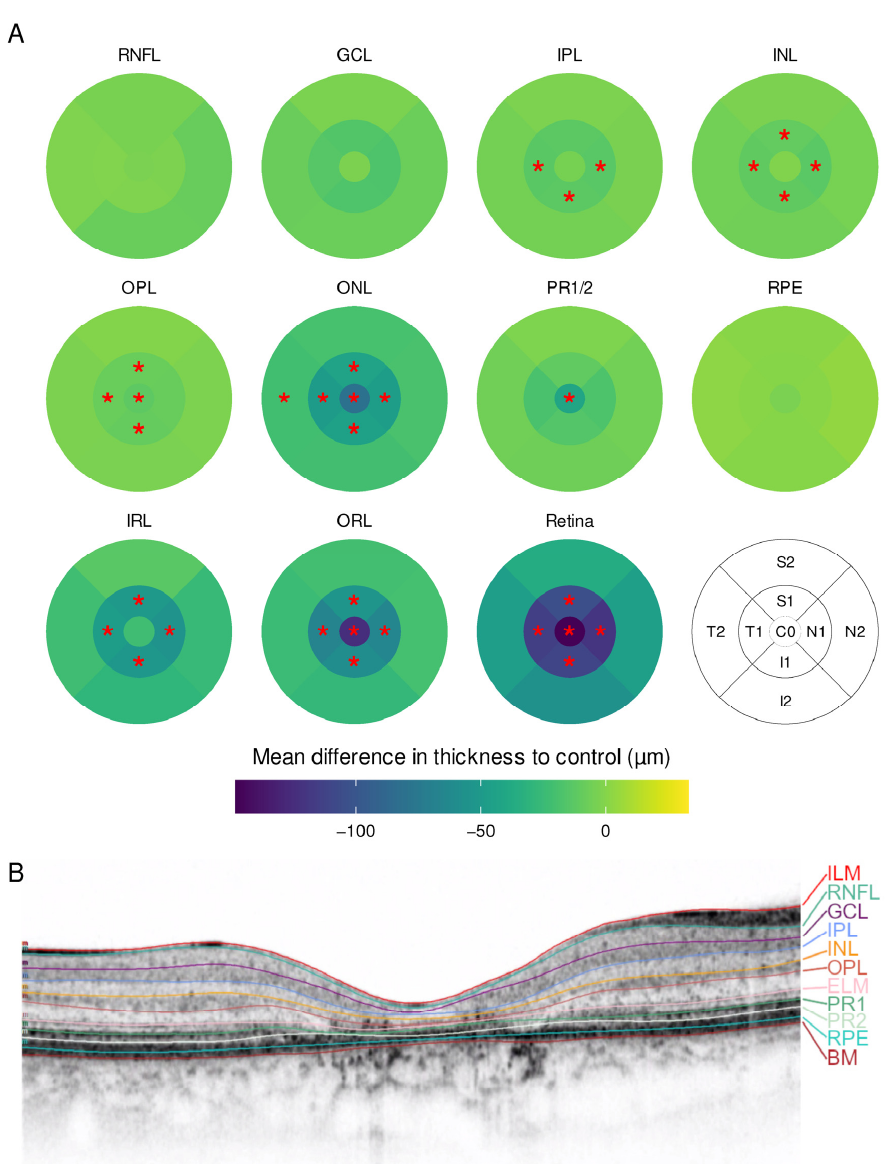
Figure 3. ( A ) Mean difference in layer thickness for Stargardt disease (STGD) compared to controls represented as a heatmap on the ETDRS grid. Significant differences are marked with a red star (*) in the particular subfield; ( B ) example for a manually segmented SD-OCT scan from the fovea from STGD patient 12.